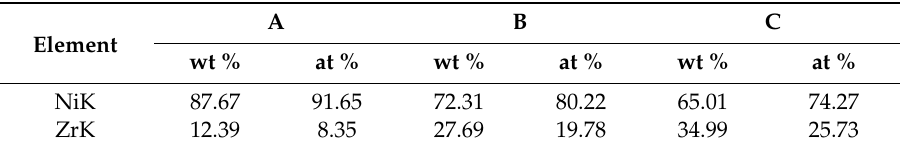
Table 2. The element content of points A, B and C.